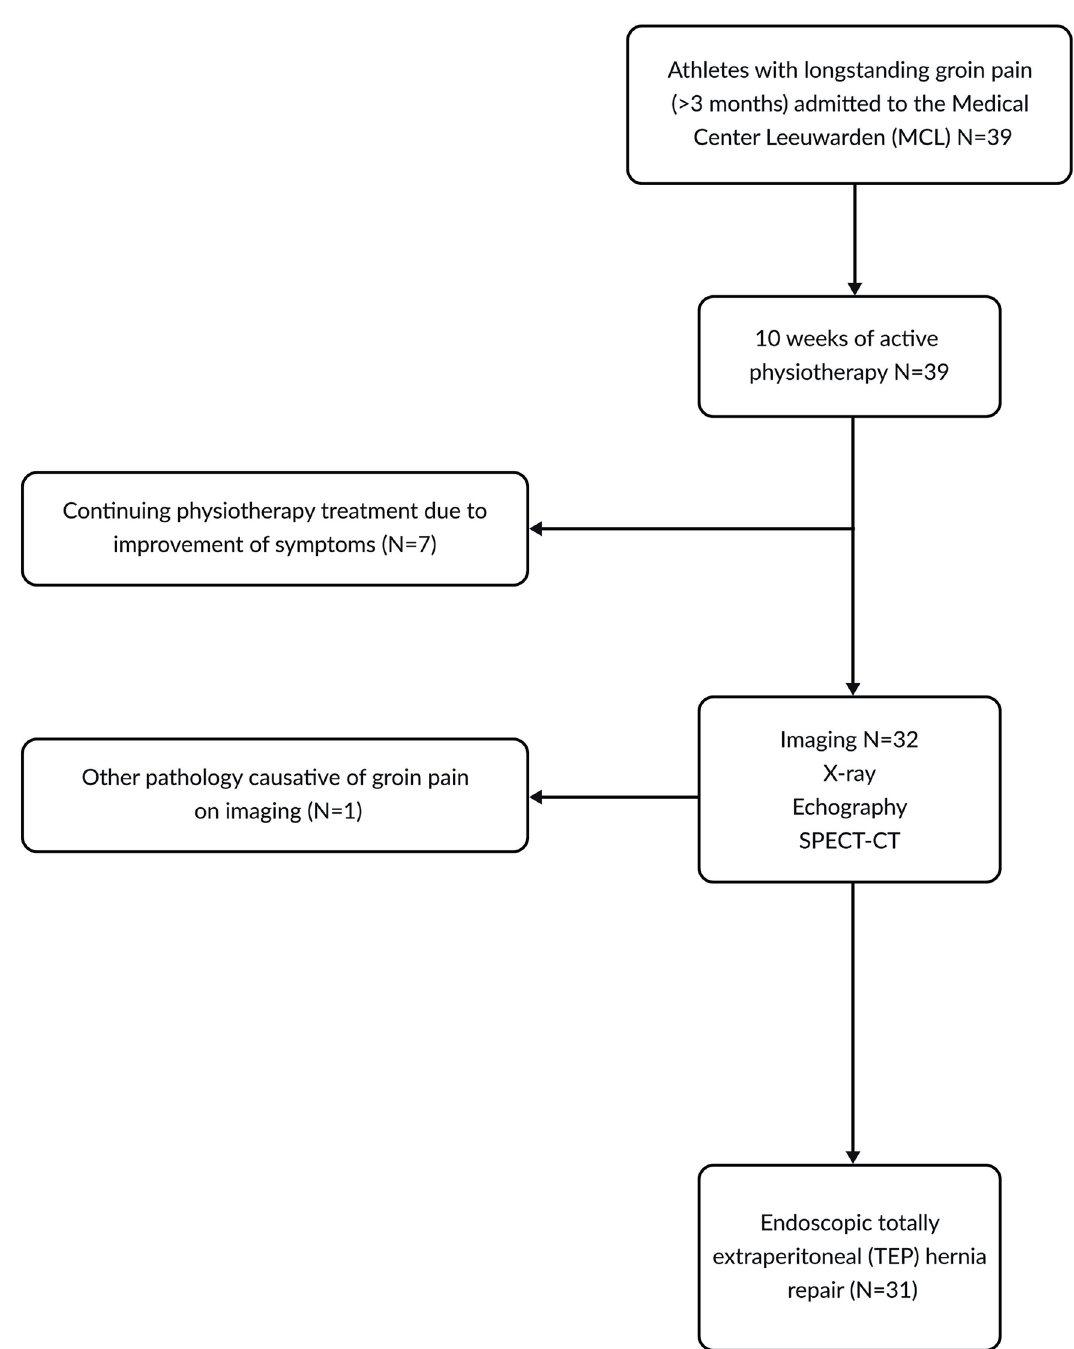
Fig 1. Flow chart for inclusion procedure of patients. Abbreviations: SPECT-CT, single photon-emission computed tomography and CT.